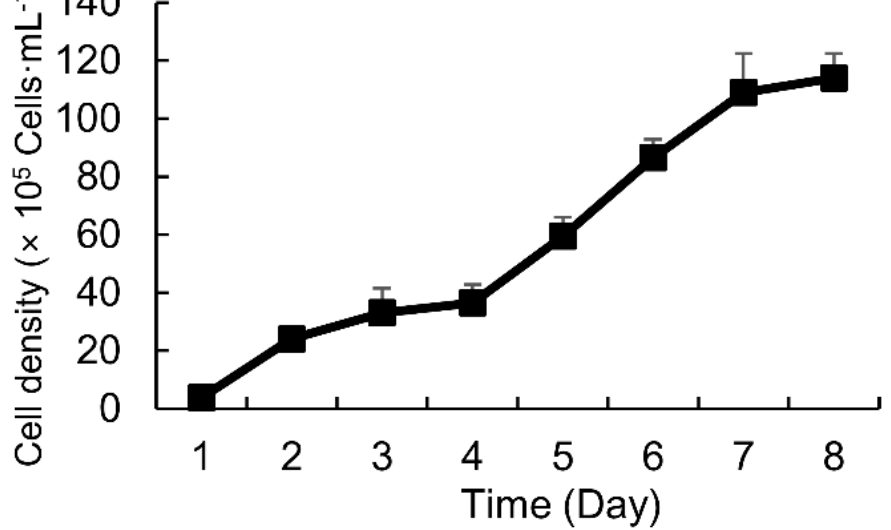
Figure 1. The growth curve of C. vulgaris in BG − 11 medium. The concentration of C. vulgaris used in the study was approximately 1 × 10 7 cells·mL −1 at day 7.